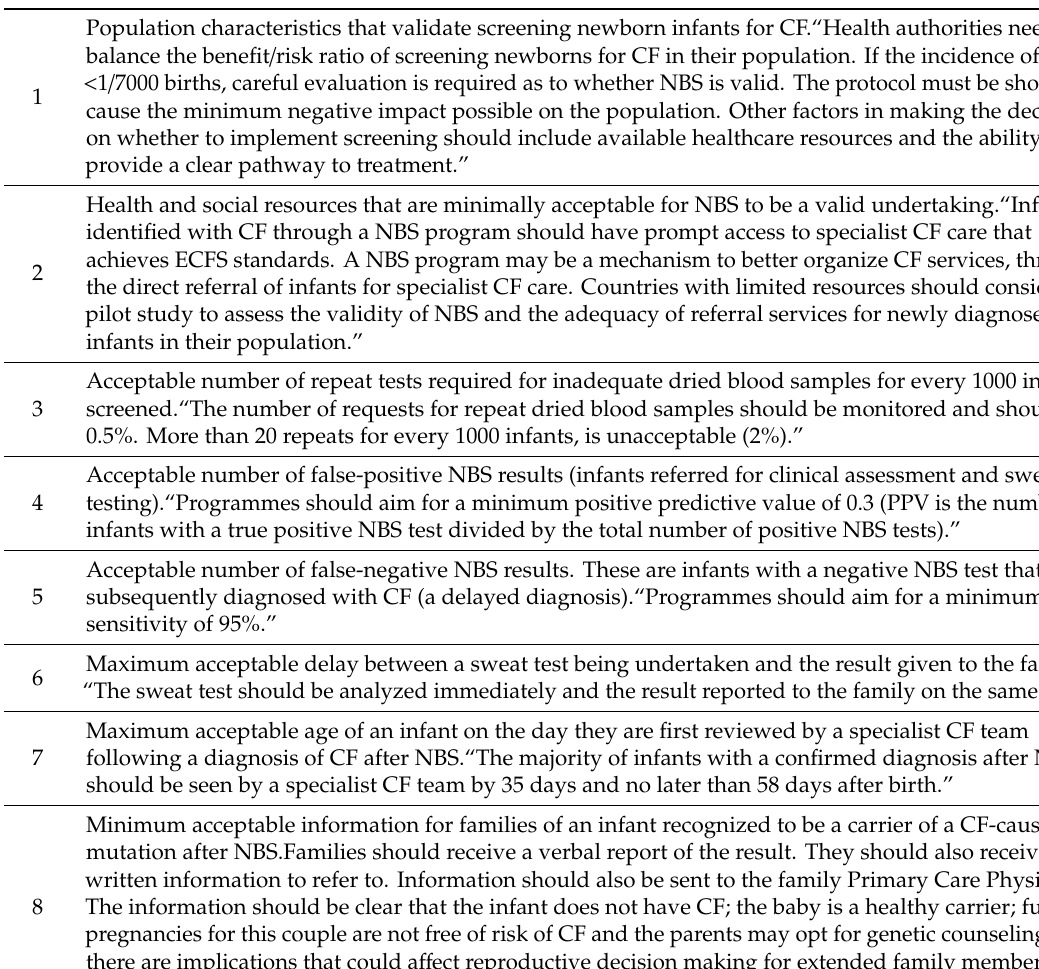
Table 2. European Cystic Fibrosis Society (ECFS) best practice guidelines: the 2018 revision